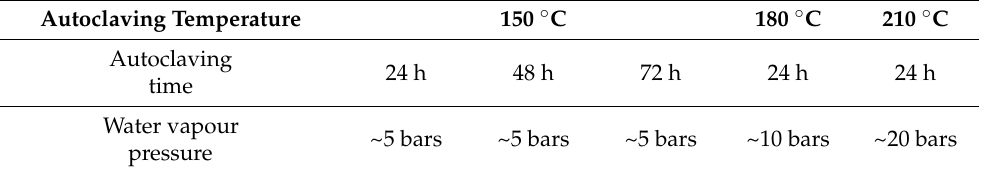
Table 1. Conditions used for autoclaving the ATZ-B, ATZ-10, ATZ-20 composites and the reference